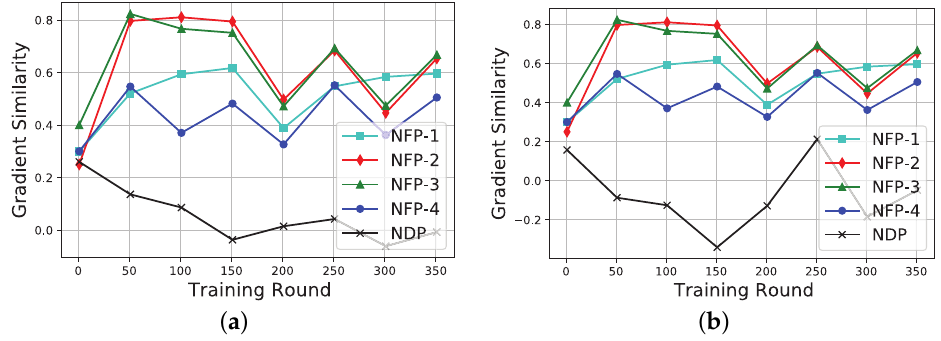
Figure 2. Variation of gradient similarity against the number of training rounds. ( a ) NDP noise data are 30%. ( b ) NDP noise data are